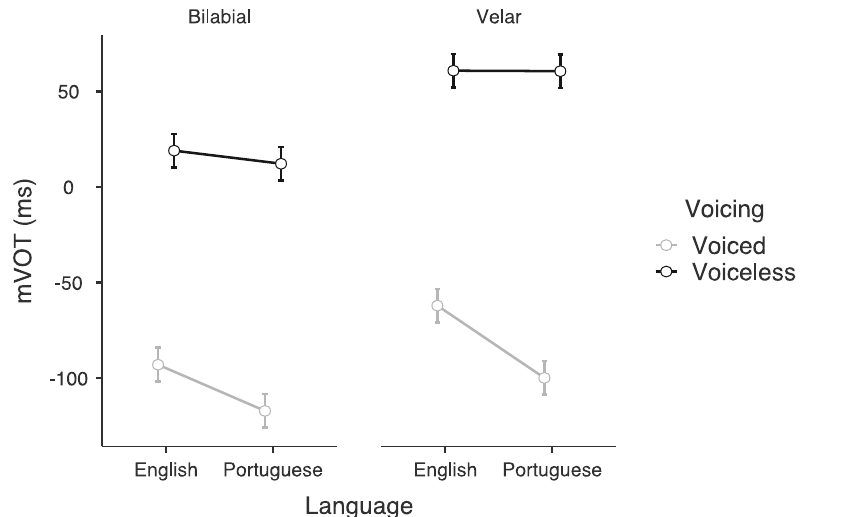
Figure 2. Mean (and 95% CI) mVOT values plotted as a function of place (bilabial, velar), voicing (voiced, voiceless), and language (L2 English, L1 Portuguese). Data come from 28 native speakers of Portuguese learning English as a foreign language in Brazil.